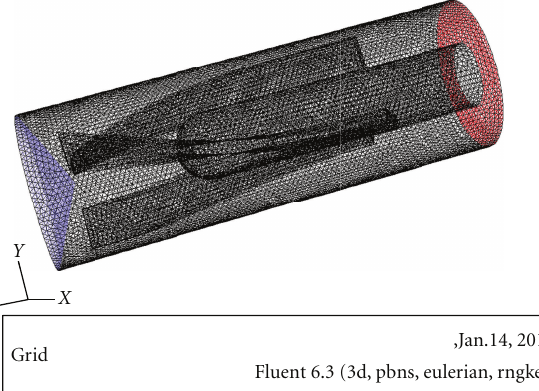
Figure 6: The grid of a turbulence